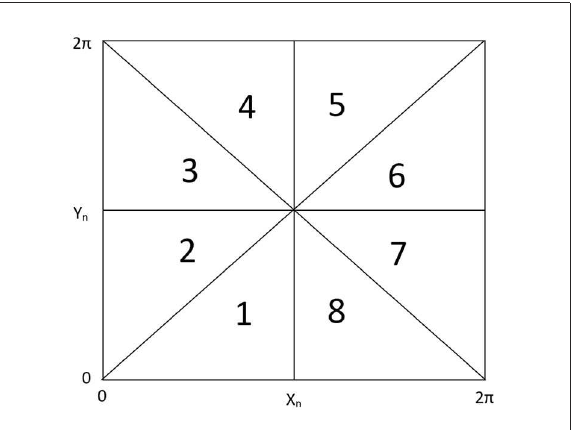
FIGURE1 Divisions of the phase space of the conservative chaotic standard map.